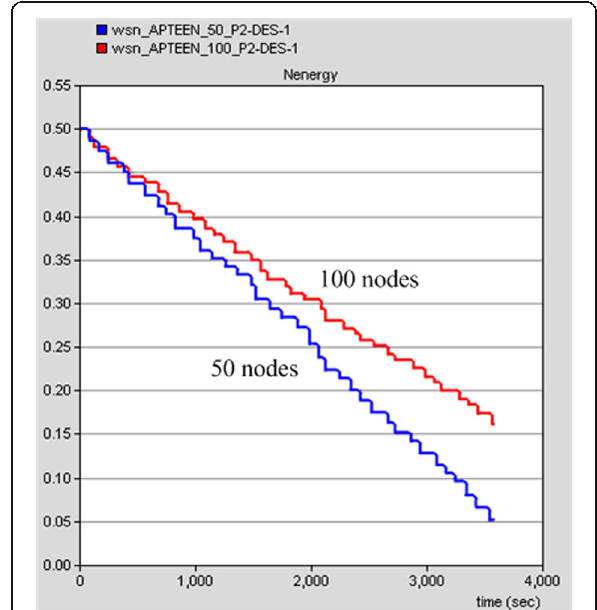
Fig. 10 Energy consumption of APTEEN compared in different scales. This figure shows a single-node energy consumption of APTEEN in different network scales. From this figure, we can see that increasing the number of nodes makes the node energy consumption more stable